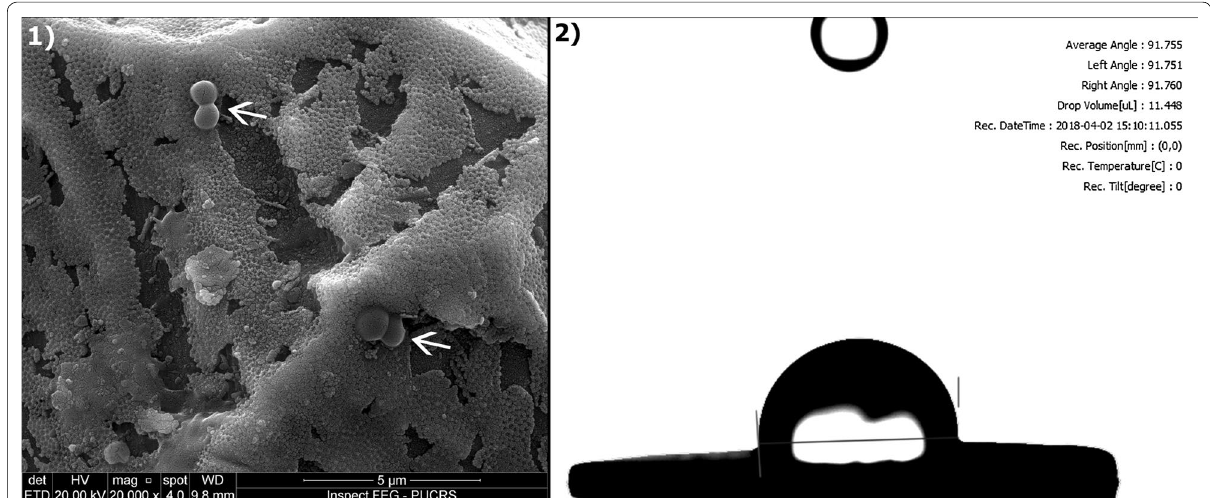
Fig. 3 SEM image showing (white arrows) a nanotube surface after adhesion assay with Staphylococcus epidermidis and fixation ( 1 ), and its previous characterization regarding wettability indicating hydrophobicity ( 2